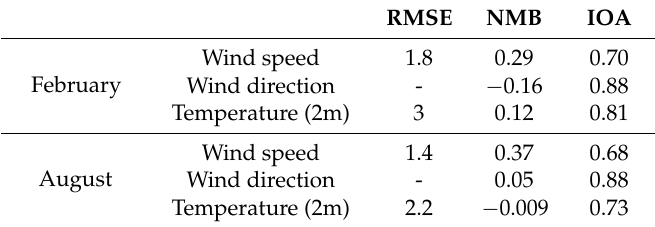
Table 1. Evaluation of hourly Weather Research Forecast (WRF) meteorology simulation.